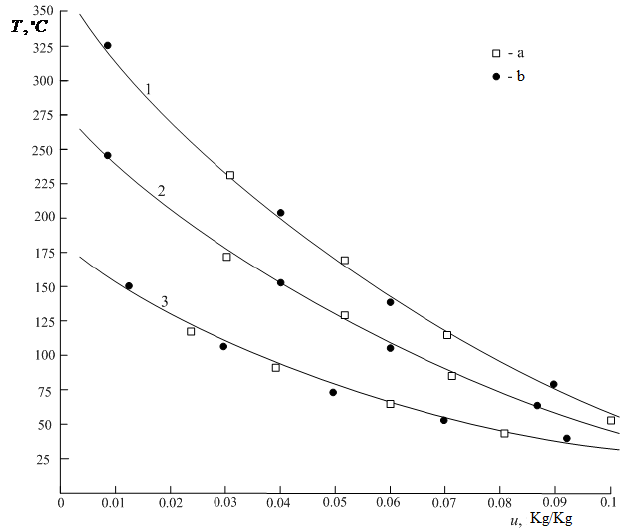
Figure 7. The temperature of the pellet at the border and in the center during drying depending on time at different temperatures of the drying agent T c : 1–500 °C, 2–400 °C, 3–300 °C, 4–200 °C, 5–100 °C (Experimental data from Talkhaev et al. [23]).